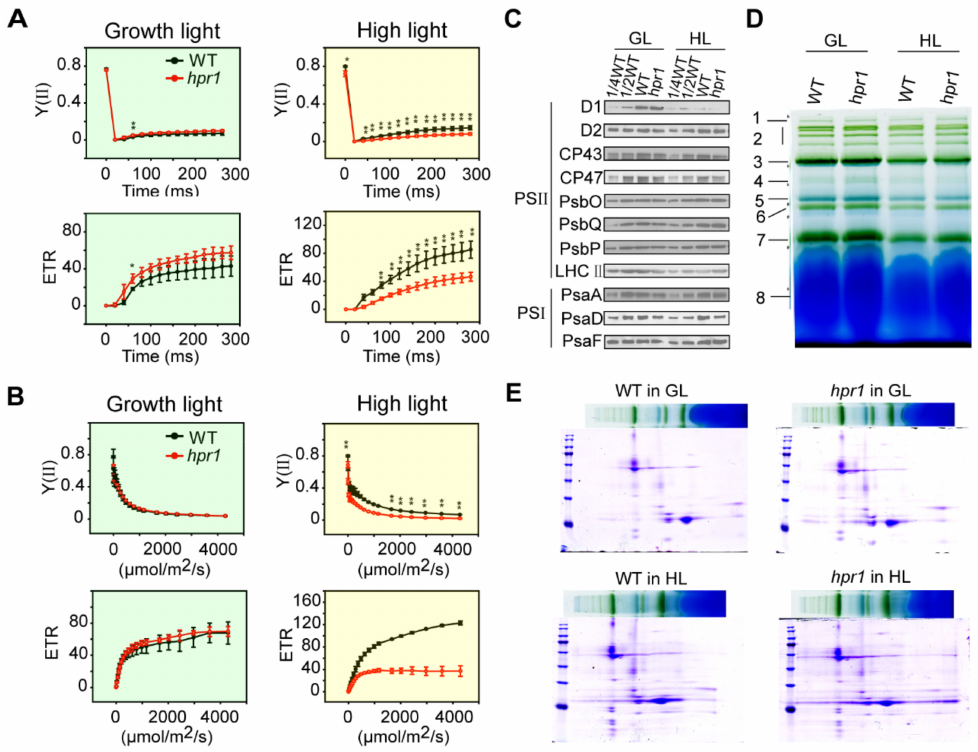
Figure 3. Photosystem analysis in WT and hpr1 mutants. ( A ) Slow chlorophyll fluorescence induction kinetics of four-week WT and hpr1 cultivated at growth light (80 µ mol · m − 2 · s − 1 ) and high light (350 µ mol · m − 2 · s − 1 ). Y(II), quantum yield of PSII photochemistry; ETR, electron transport rate through PSII. Values shown are means ± SD, n = 3, with three independent replicates. Asterisks show significant differences compared to WT: *, p < 0.05; ** p < 0.01 (Student’s t -test). ( B ) Light response curves of PSII of four-week-old WT and hpr1 cultivated at growth light of 80 µ mol · m − 2 · s − 1 and high light intensity of 350 µ mol · m − 2 · s − 1 . Values shown are means ± SD, n = 3, with three independent replicates. Asterisks show significant differences compared to WT: * p < 0.05; **, p < 0.01 (Student’s t -test). ( C ) Western blot analysis of photosystem proteins in four-week-old WT and hpr1 mutant plants under growth light (GL, 80 µ mol · m − 2 · s − 1 ) and high light intensity (HL, 350 µ mol · m − 2 · s − 1 ). Immunoblot analysis was performed with antibodies against the indicated thylakoid membrane proteins. ( D ) Blue native gel analysis of photosynthetic complexes of four-week-old WT and hpr1 mutant plants. Annotation of the different complexes: 1, NDH-PSI; 2, PSII supercomplexes; 3, PSI monomer, PSII dimer and PSII monomer with LHCII trimers; 4, PSI monomer and CF 1 complex; 5, PSII monomer; 6, LHCII assembly; 7, LHCII trimers; 8, LHCII monomers. ( E ) Thylakoid proteins separated by BN gel in ( D ) were further subjected to the second dimension SDS